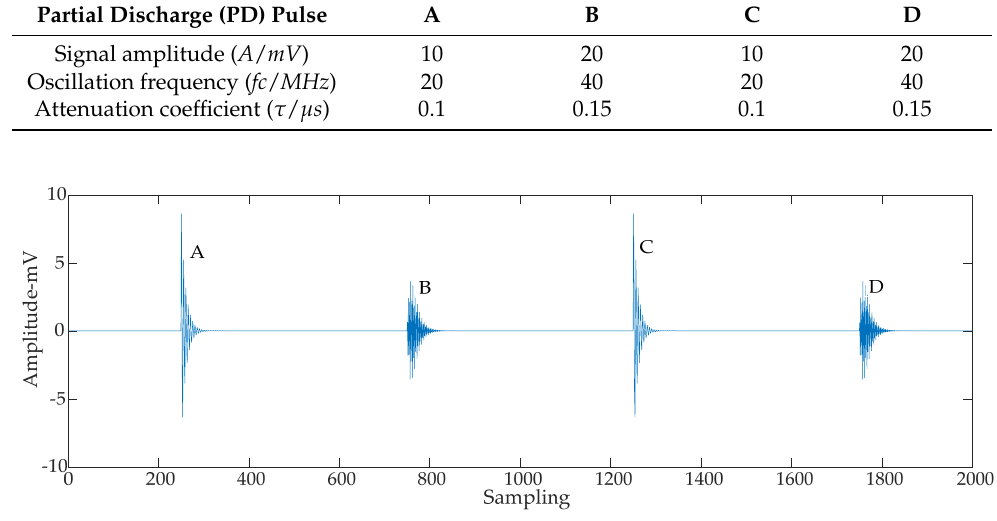
Table 1. PD Simulation signal parameters.